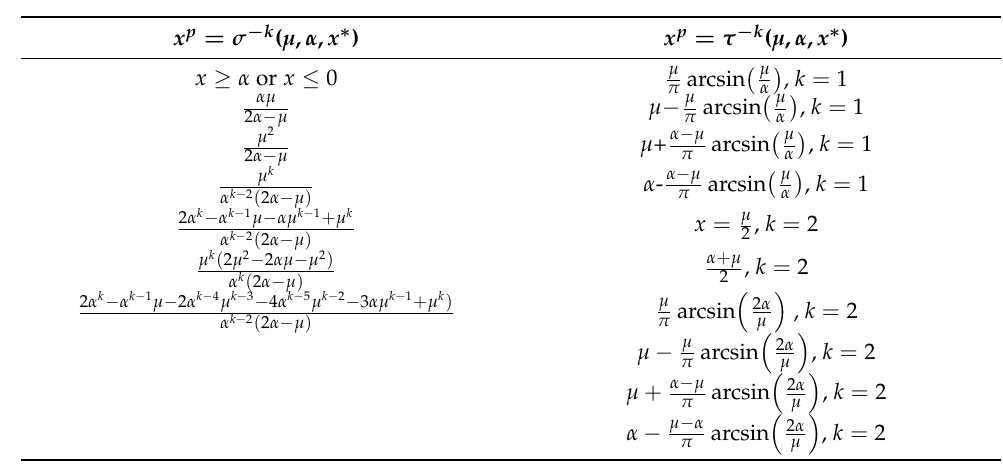
Table 2. Some preimages of fixed points for the two chaotic maps considering 0 < µ < α and α < 2 π and k =